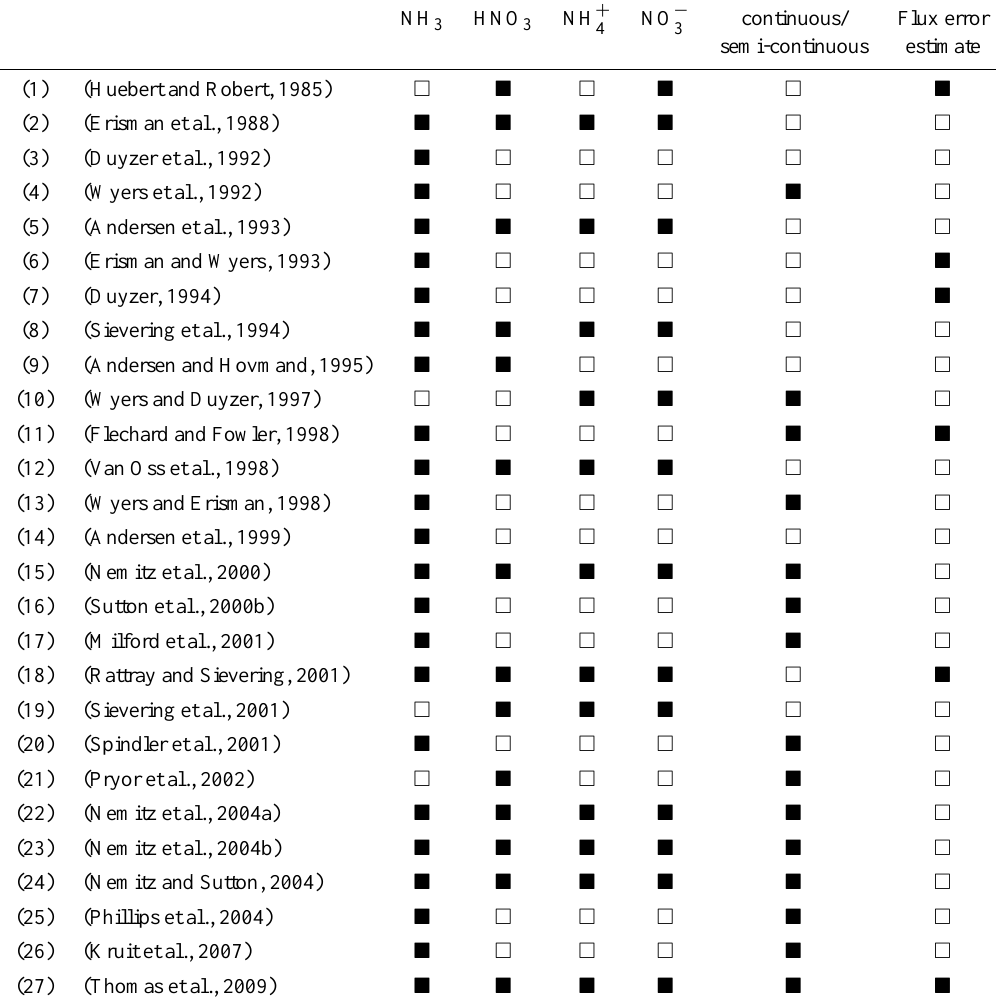
/NO − . Indicated are the 4 3